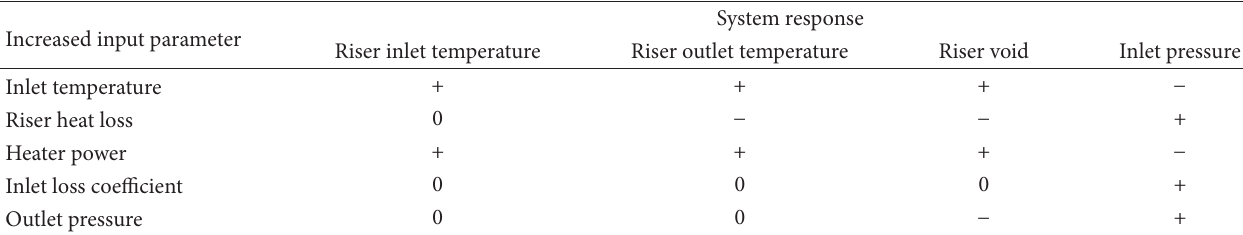
Table 3: Test section response to the variation of the input parameters.